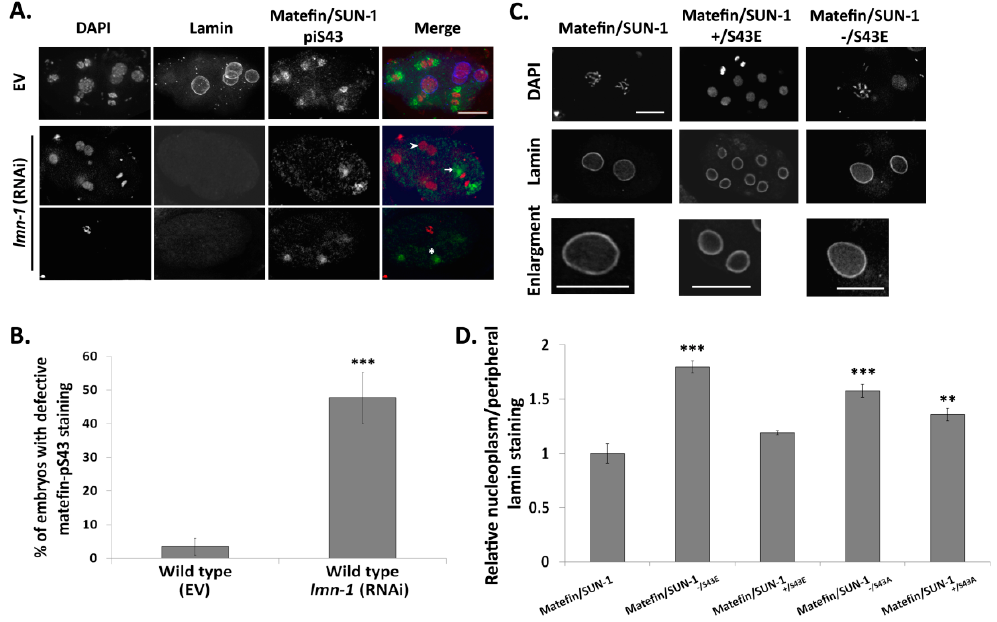
Figure 5. Matefin1/SUN ‐ 1 pS43 requires lamin for its proper localization. lmn ‐ 1 (RNAi) disrupts matefin/SUN ‐ 1 pS43 localization in early C. elegans embryos. ( A ) wild type embryos stained with DAPI (red), anti ce ‐ lamin (blue) and anti matefin/SUN ‐ 1 pS43 (green) antibodies. Top panel—embryo treated with EV; Bottom three panels—embryos treated with lmn ‐ 1 (RNAi); ( B ) percentage of embryos displaying aberrant pS43 matefin/SUN ‐ 1 localization (p value = 1.07 × 10 − 6 ); ( C ) lamin localization was analyzed in embryos expressing matefin/SUN ‐ 1 S43 phosphorylation mutations. Embryos were stained with DAPI and anti ce ‐ lamin antibodies; Scale bar 10 μ m ( D ) quantification of the relative nucleoplasmic/peripheral ce ‐ lamin staining in matefin/SUN ‐ 1 S43 mutant embryos. matefin/SUN ‐ 1 − /S43E p value = 6.6 × 10 − 8 ; matefin/SUN ‐ 1 +/S43E p value = 0.06; matefin/SUN ‐ 1 − /S43A p value = 1.3 × 10 − 5 ; matefin/SUN ‐ 1 +/S43A p value = 0.002. Error bars represent SEM. * p < 0.05, ** p < 0.005, *** p < 0.0005 as compared to wild ‐ type.